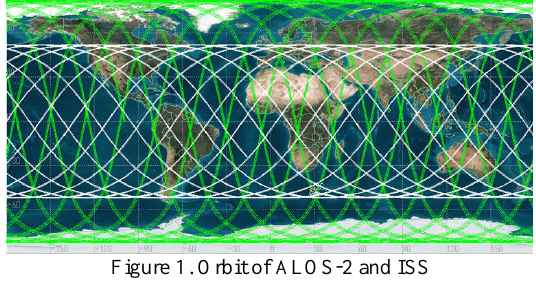
Figure 1. Orbit of ALOS-2 and